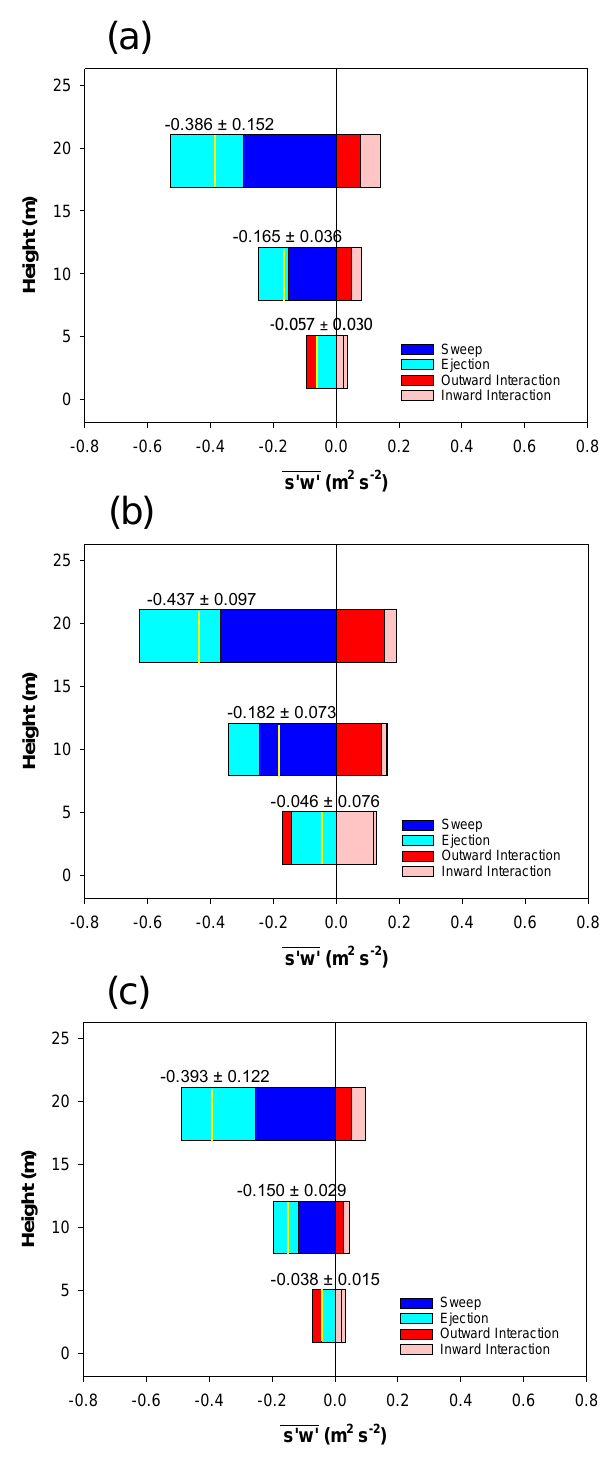
Figure 7. Mean contributions of sweep, ejection, outward interaction, and inward interaction events to the average vertical turbulent momentum fluxes during the ( a ) pre-FFP, ( b ) FFP, and ( c ) post-FFP periods at 3 m, 10 m, and 19 m AGL, computed from all five in situ towers. Average total vertical turbulent momentum flux values (m 2 s −2 ) at each height level are indicated with labeled (mean ± standard deviation) yellow vertical lines.